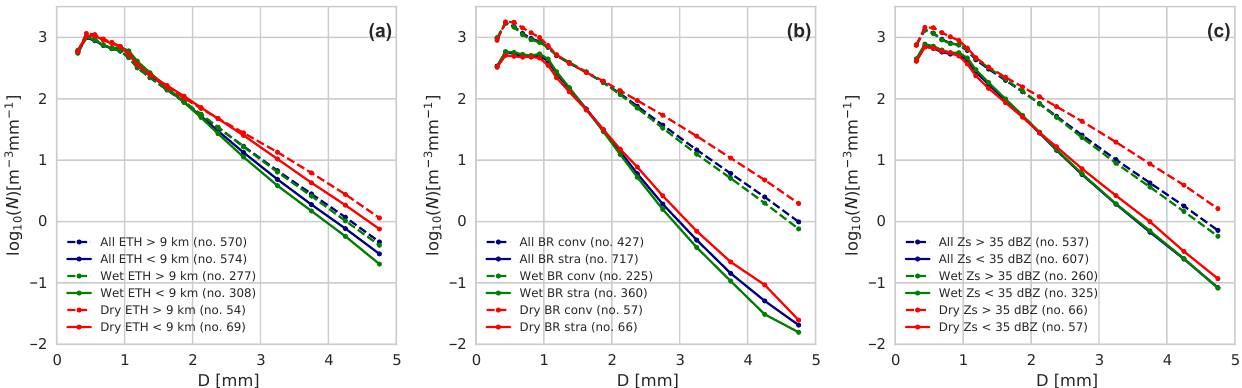
Figure 14. Averaged RWP-based convective DSDs for congestus (ETH < 9km) and deep (ETH > 9km) DSDs (a) , for convective and stratiform DSDs depending on the BR separation (b) , and for those having Z (at surface) < 35dBZ and Z > 35dBZ (c) , for all, dry and wet seasons.